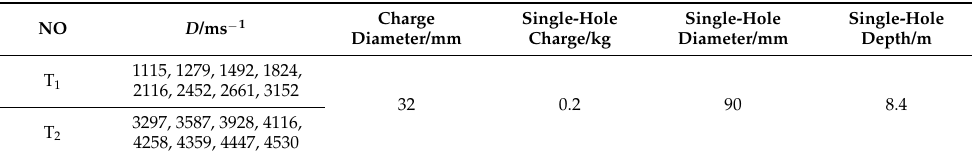
Table 11. The parameters of single-hole blasting test parameters.